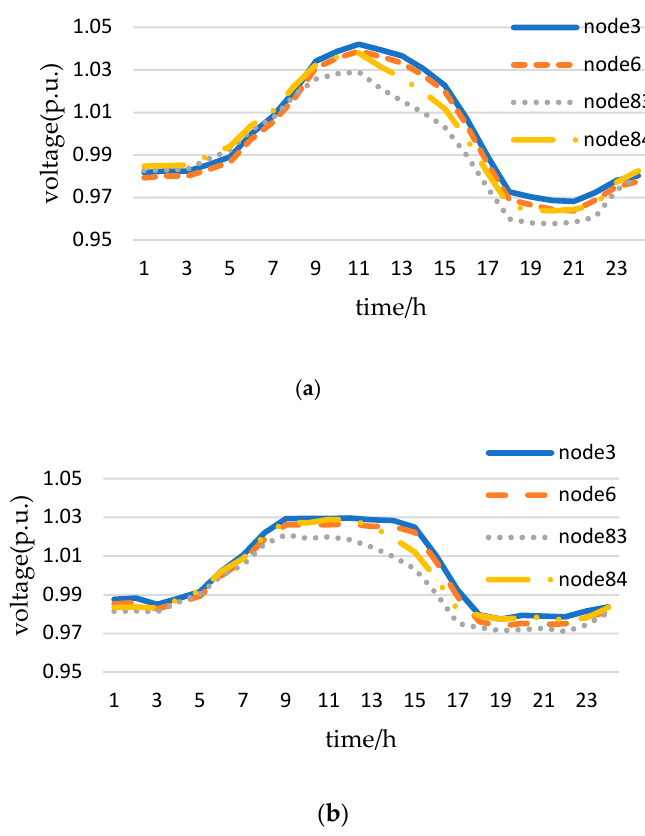
Figure 9. Voltage profiles of each typical node before ( a ) and after ( b ) the ESS configuration.